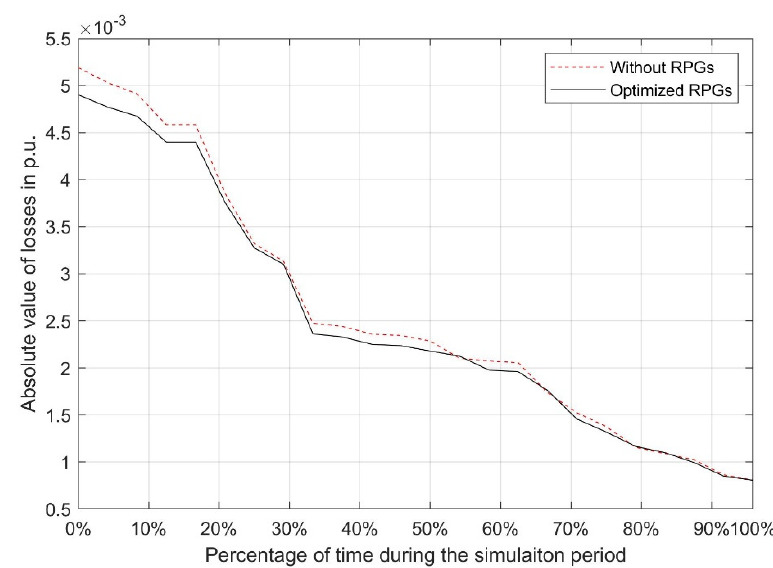
Figure 15. Loss reduction in the IEEE 30-bus system.